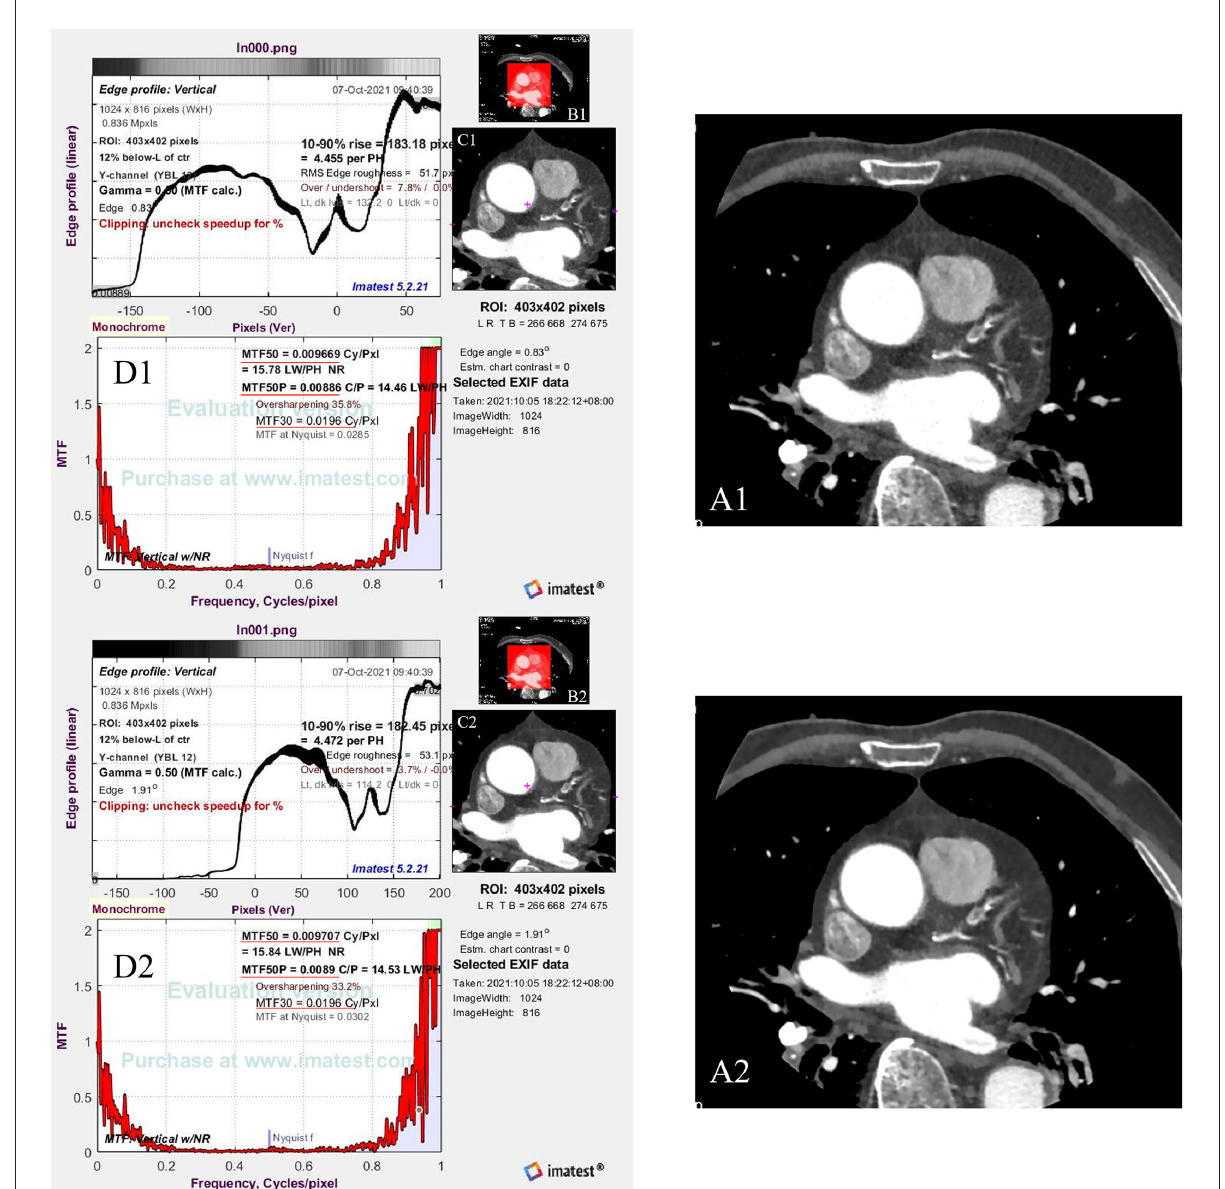
FIGURE3 The flow chart shows how to calculate the image sharpness. (A1,A2) are the same Digital Imaging and Communications in Medicine (DICOM) slices of the beginning of the coronary sinus of one patient [ (A1) from the routine group and (A2) from the SE group], which are exported to be a PNG format (Portable Network Graphic). Red frames in (B1,B2) are the setting of ROI (region of interest) (C1,C2) . Then, the software calculates the image sharpness through the ROI based on the MTF50, MTF50P, and MTF 30 [red underlines in (D1,D2) ].